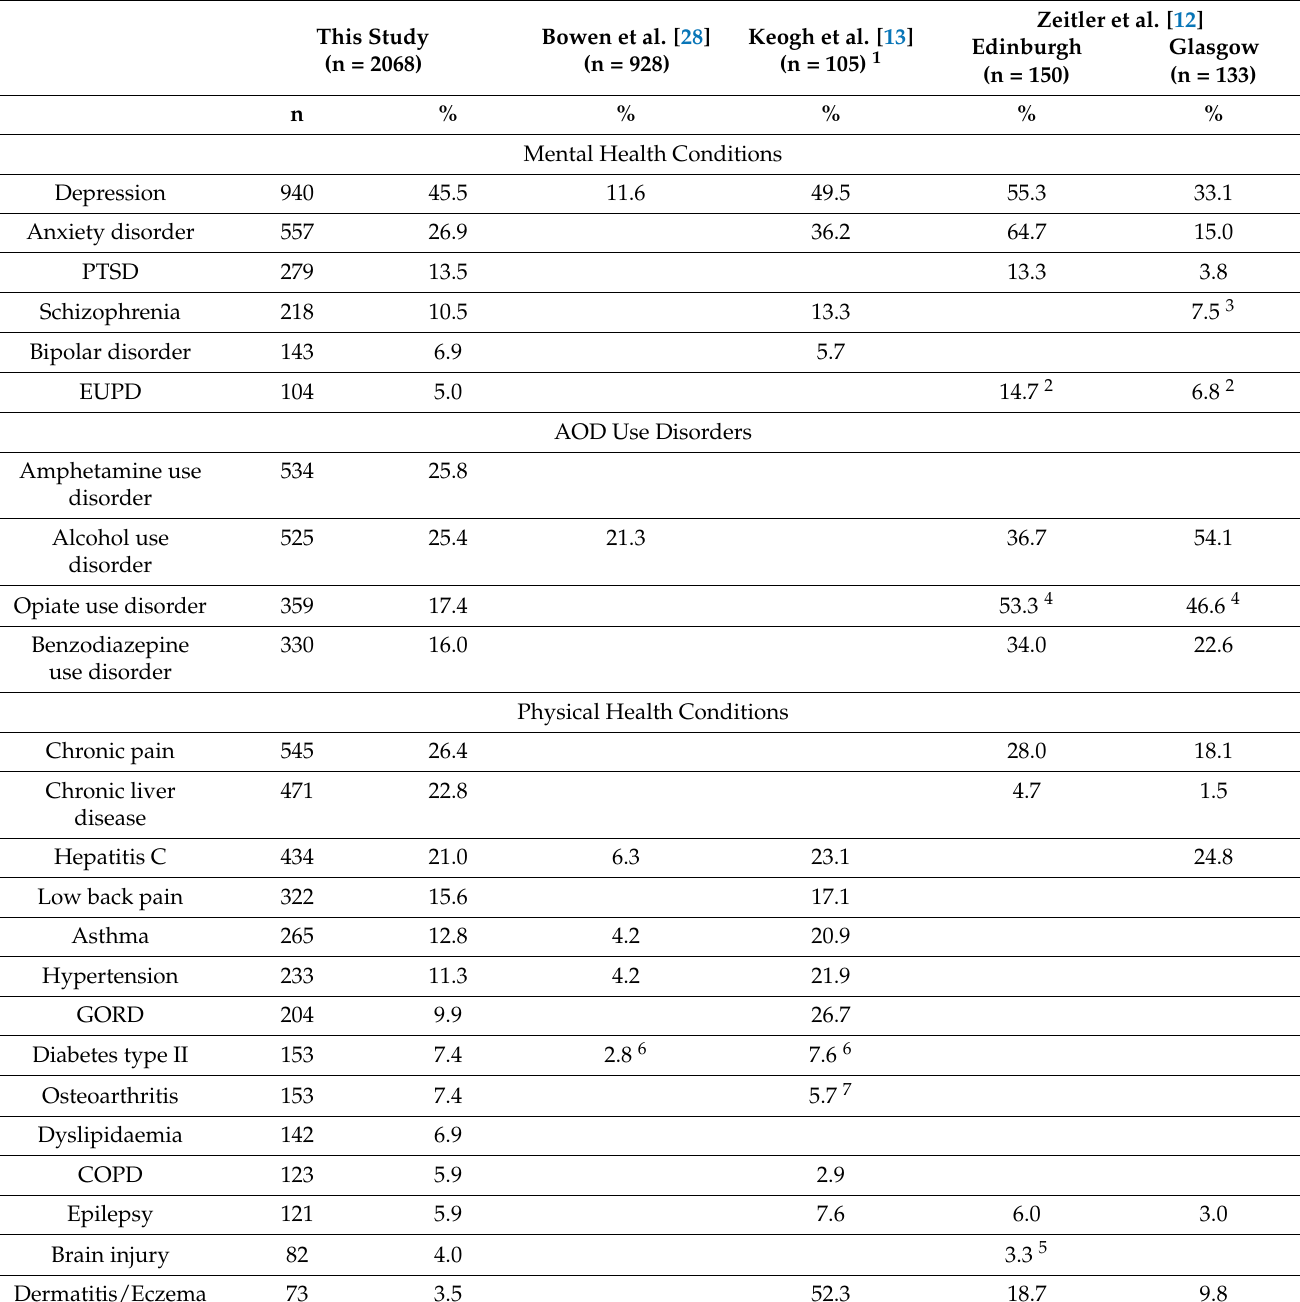
Table 3. Unadjusted Proportion of Homeless General Practice Patients with “ever recorded” Condition–Comparison to Homeless